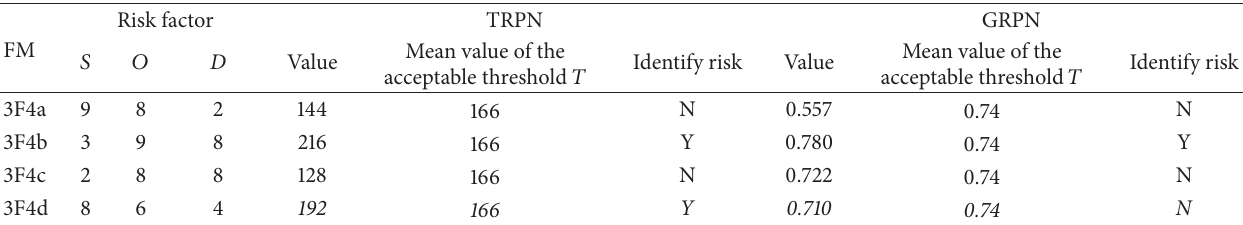
Table 11: Comparison of the TRPN and GRPN test procedures—scenario